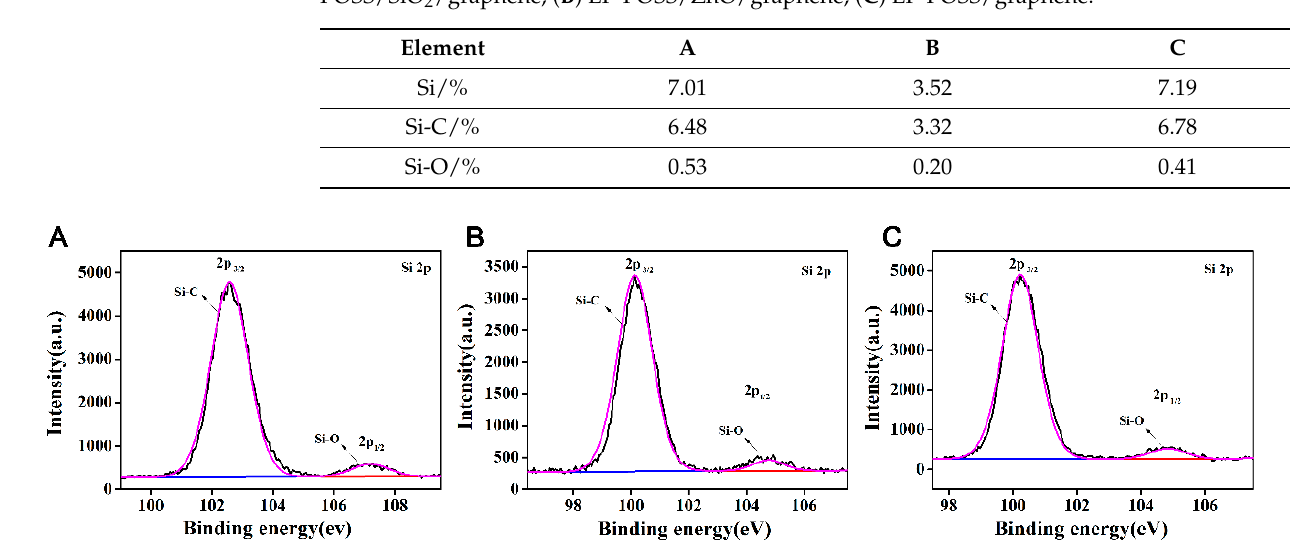
Table 2. Adhesion and wear resistance test of EP-POSS